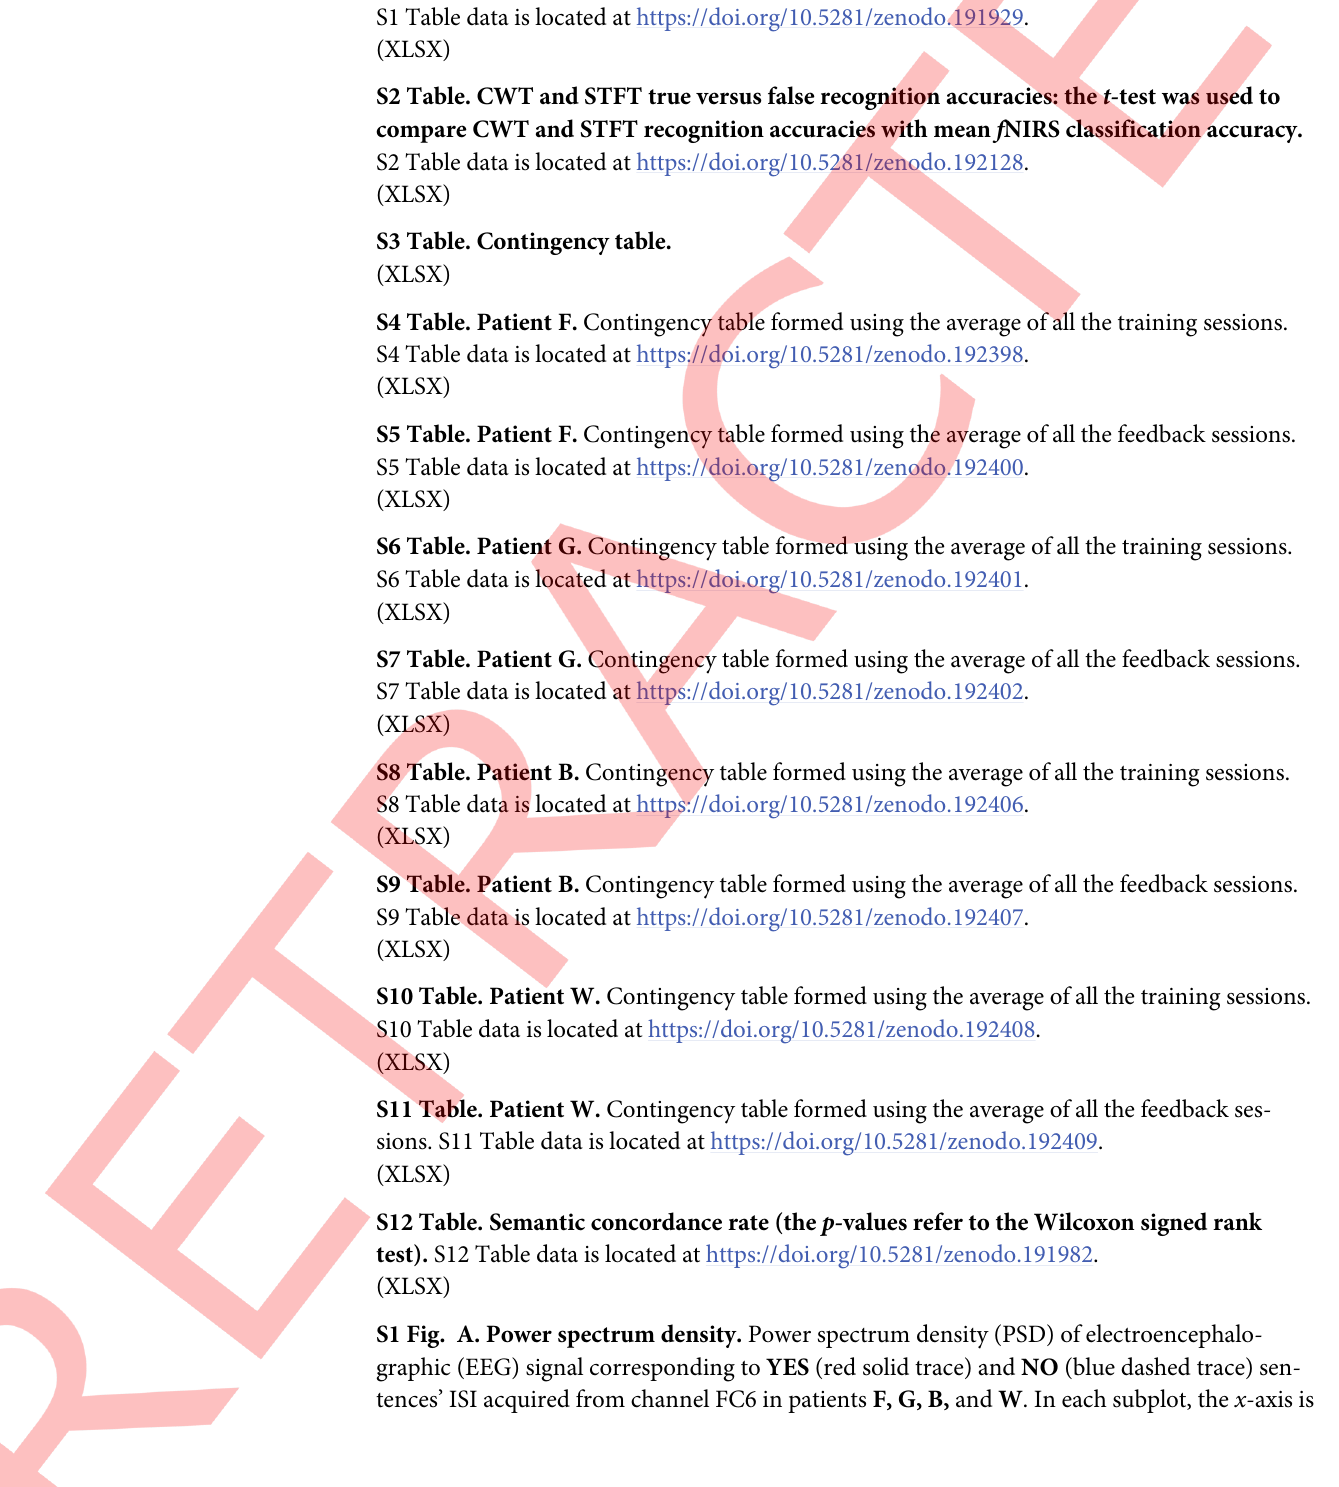
S12 Table. Semantic concordance rate (the p -values refer to the Wilcoxon signed rank